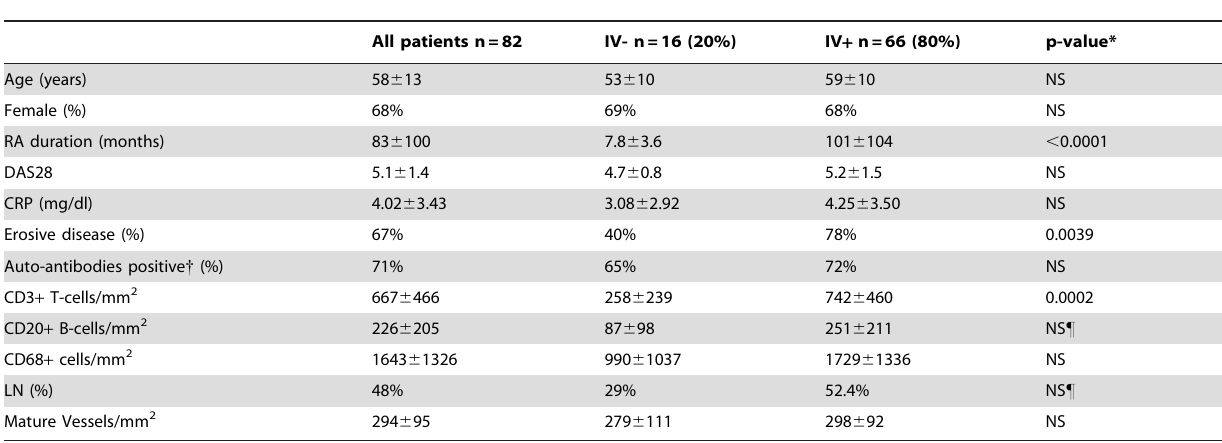
Table 2. Clinicopathological data stratified by the presence of Immature Vessels (IV).